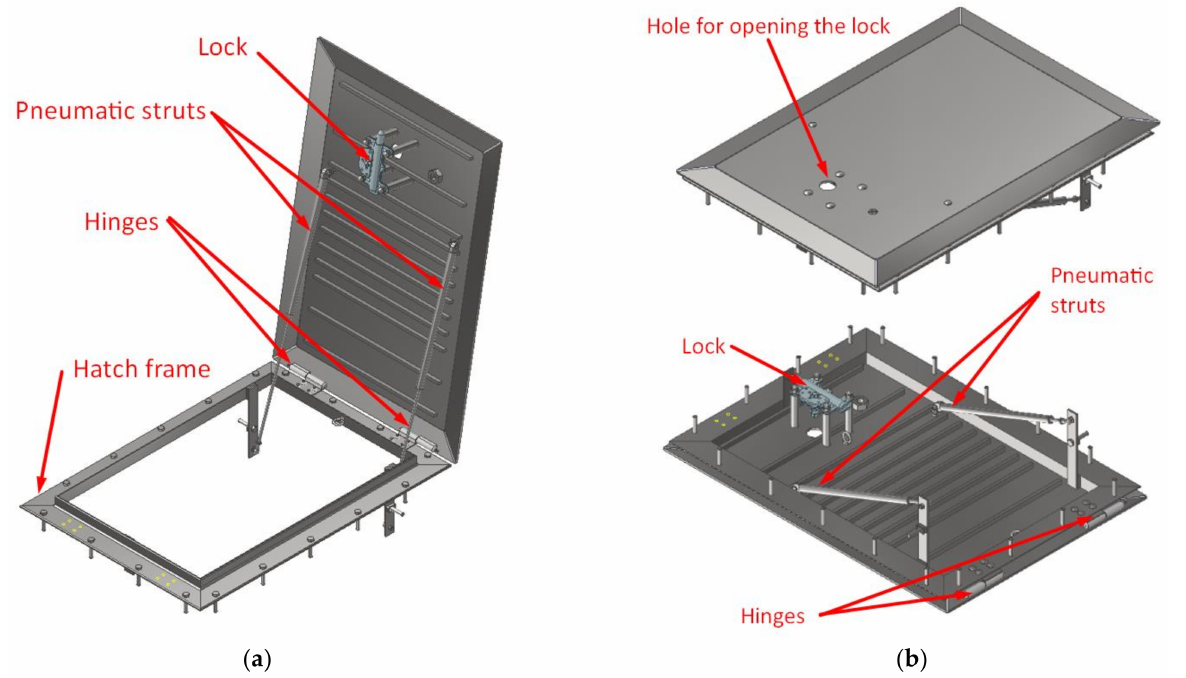
Figure 11. Description of hatch parts. ( a ) Hatch in the open position. ( b ) Hatch in the closed position.